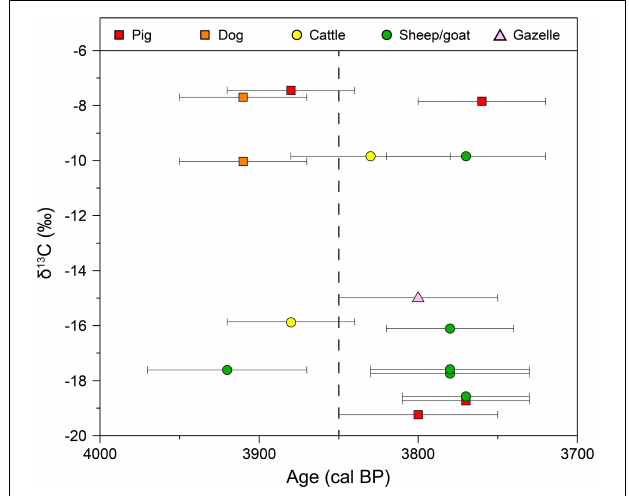
FIGURE 4 | Plot of precise ages and δ 13 C -values of the 15 directly dated samples. The dot and bar represent the mean value and SD (1 σ ) of each calibrated age, respectively. The gray dotted line at 3,850 BP roughly divided the ages into early and late phases.